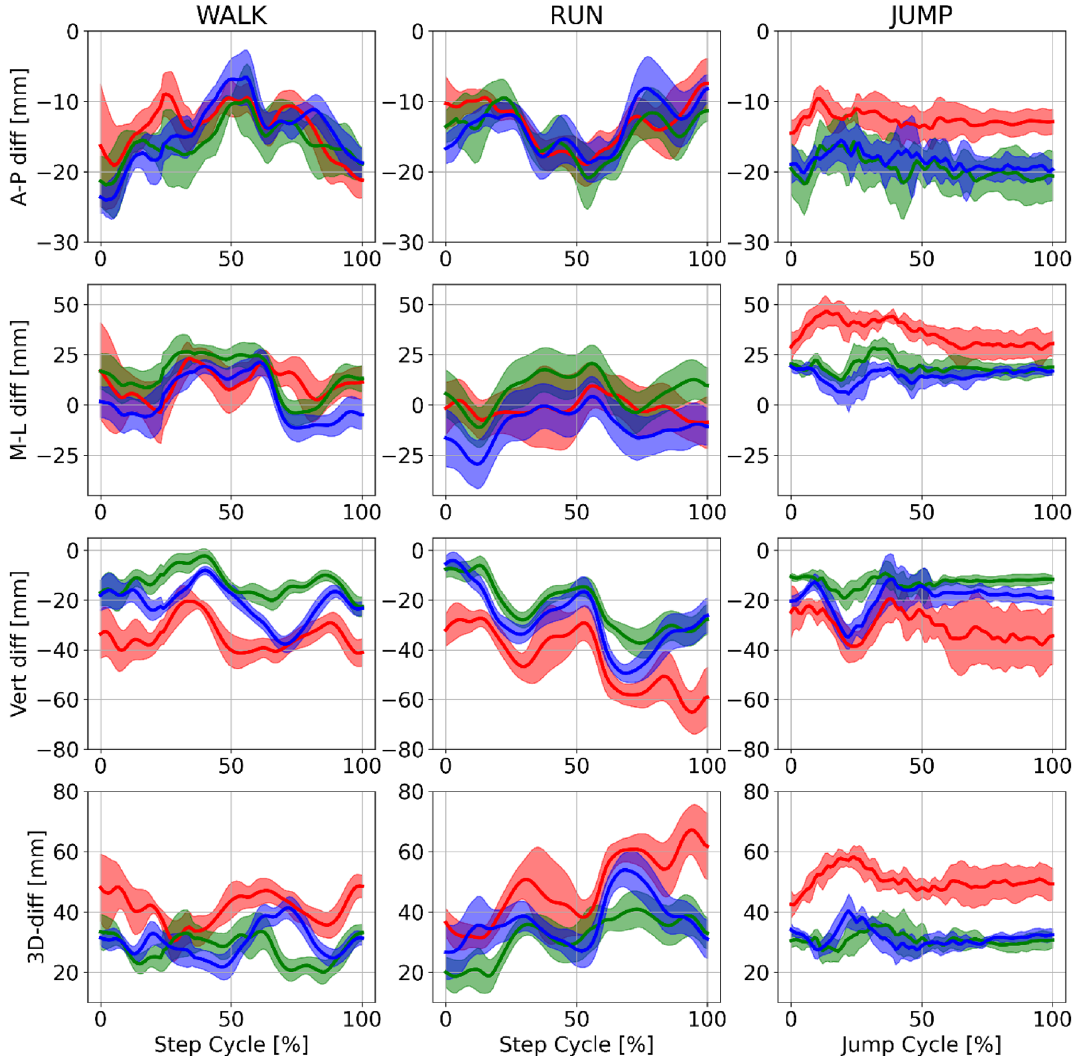
Figure 3. Example mean (± SD) differences between marker based and markerless trajectories for the right hip joint centre trajectories of a single participant (P10) during walking (left), running (centre) and jumping (right). Marker based trajectories (black), OpenPose (green), AlphaPose (blue) and DeepLabCut (red). Row 1 = anterior–posterior differences. Row 2 = medial–lateral. Row 3 = superior–inferior differences. Row 4 = 3D Euclidean